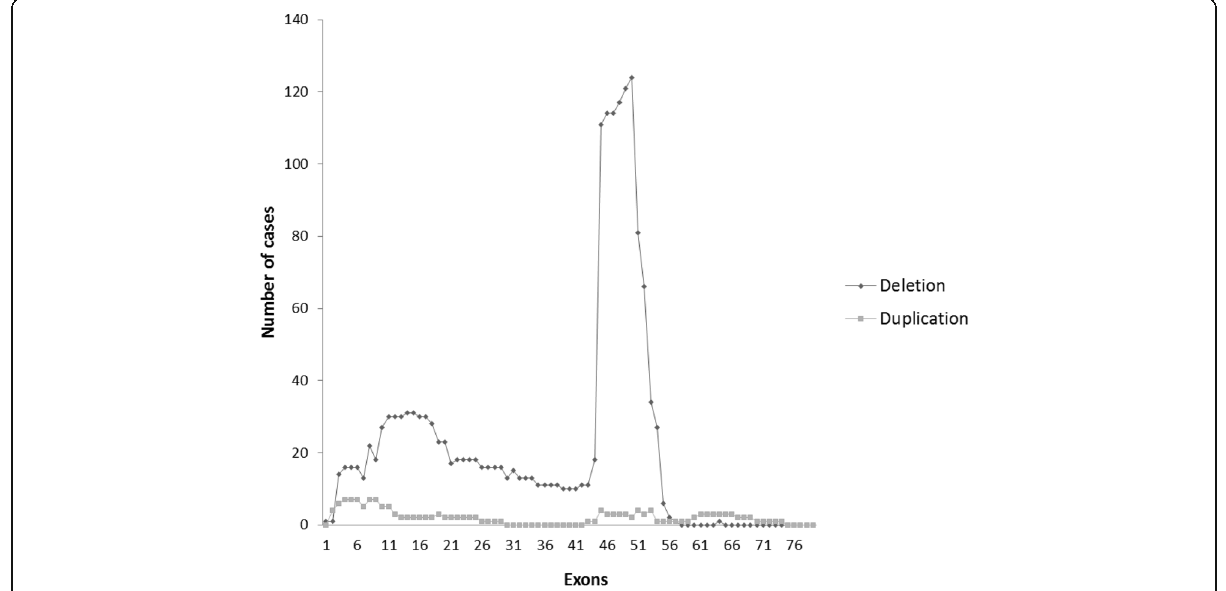
Fig. 2 Mutational frequency of each exon in the DMD